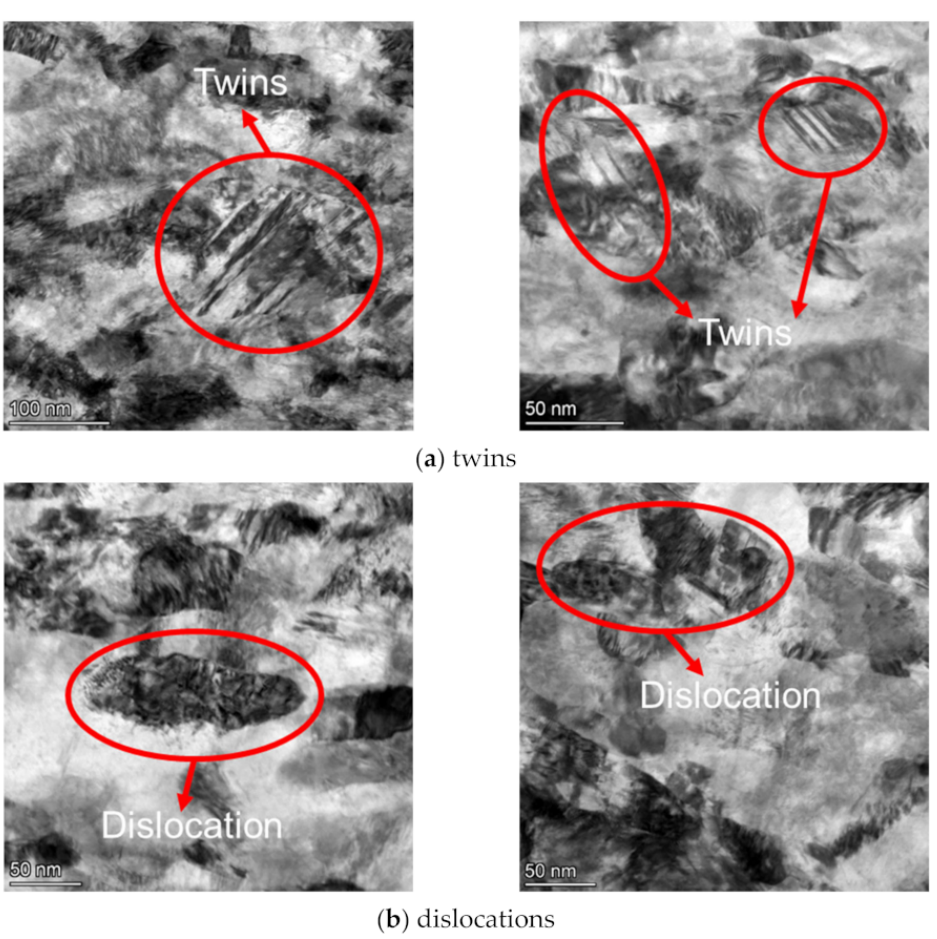
Figure 8. Twins and dislocations at the depth of 1 µ m (ultra-fine grain region) of the specimen with